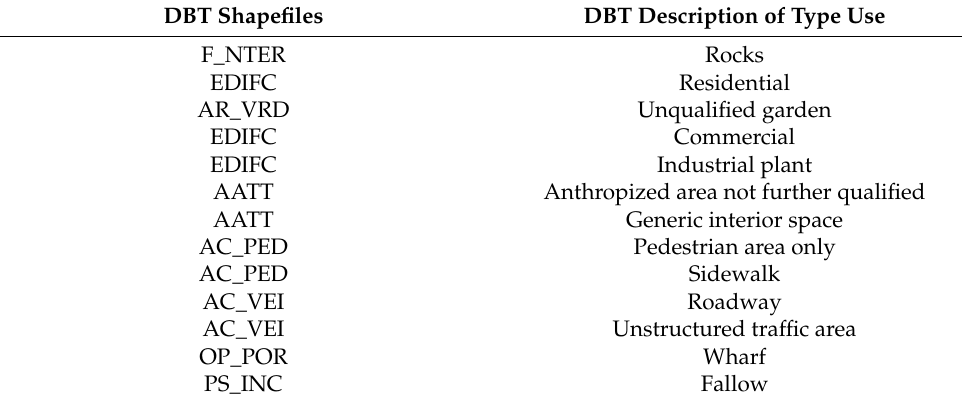
Table 4. DBT list of shapefiles selected with their descriptions.